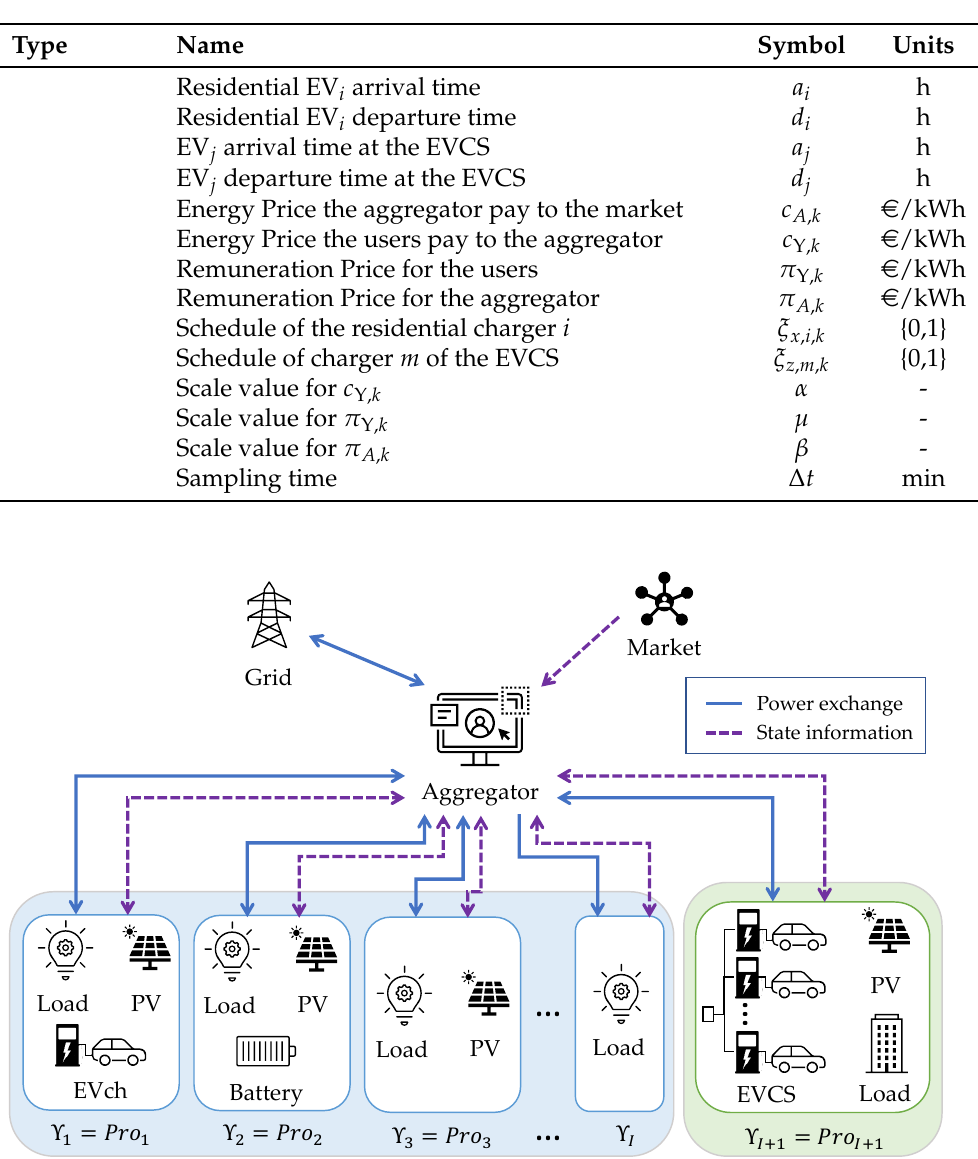
Figure 1. General scheme between an Aggregator and different